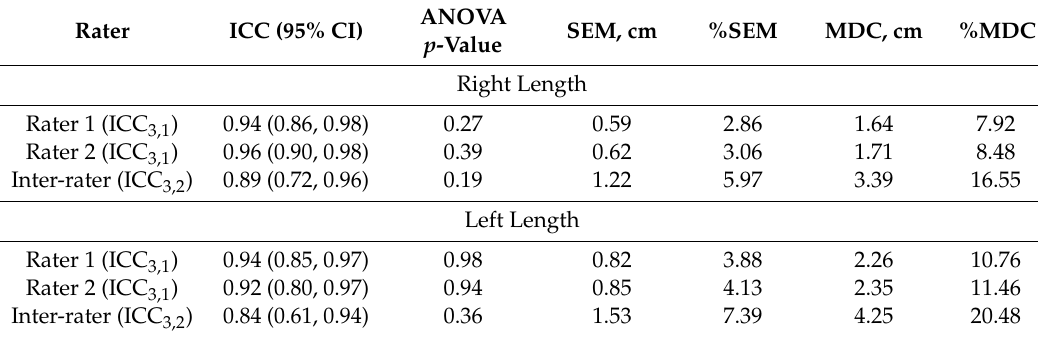
Table 3. Reliability of lower trapezius muscle measurements.